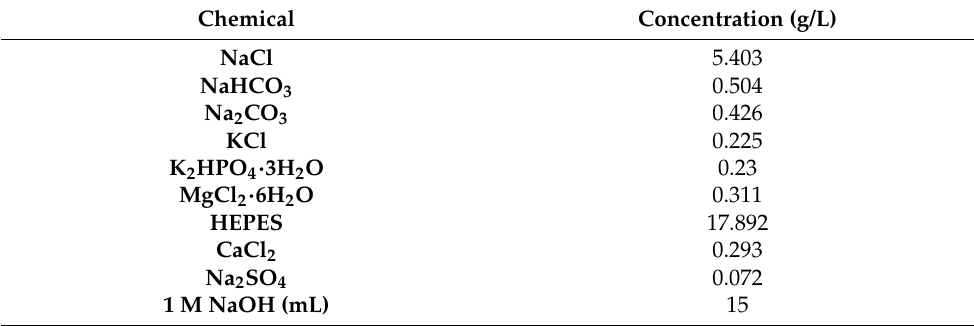
Table 1. Chemical composition of 1 L of